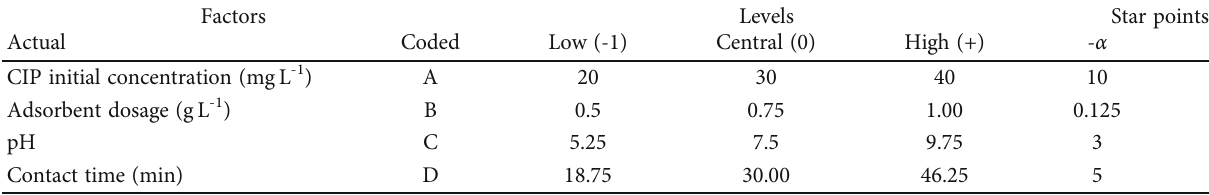
Table 1: The independent variables and their levels in the CCD experimental